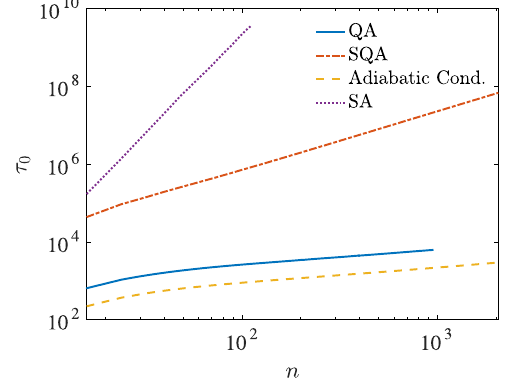
FIG. 5. Performance of different algorithms for the fixed plateau problem with l ¼ 0 and u ¼ 6 . Shown is a log-log plot of the scaling of the time to reach a threshold success probability of 0.9, as a function of system size n for AQA, SQA ( β ¼ 30 , 20 ). The time for SQA and SA is N τ ¼ 64 ) and SA ( β f ¼ measured in single-spin updates (for SQA this is N τ times the number of sweeps times the number of spins, whereas for SA this is the number of sweeps times the number of spins), where both are operated in “ solver ” mode as described in Appendix D. Also shown is the scaling of the numerator of the adiabatic condition as defined in Eq. (15). The scaling for AQA and the adiabatic condition extracted by a fit using n ≳ 10 2 is approximately n 0 . 44 . However, the true asymptotic scaling is likely to be ∼ n 0 . 5 since the scaling for the fixed plateau problem is clearly lower bounded by the plain Hamming weight problem, for which we have verified τ 0 ∼ n 0 . 5 (see Appendix A), and we expect the effect of the plateau to become negligible in the large n limit. SQA scales more favorably ( ∼ n 1 . 5 ) than SA ( ∼ n 5 ). We have checked that the scaling of SQA does not change even if we double the number of Trotter slices N τ and keep the temperature 1 = β